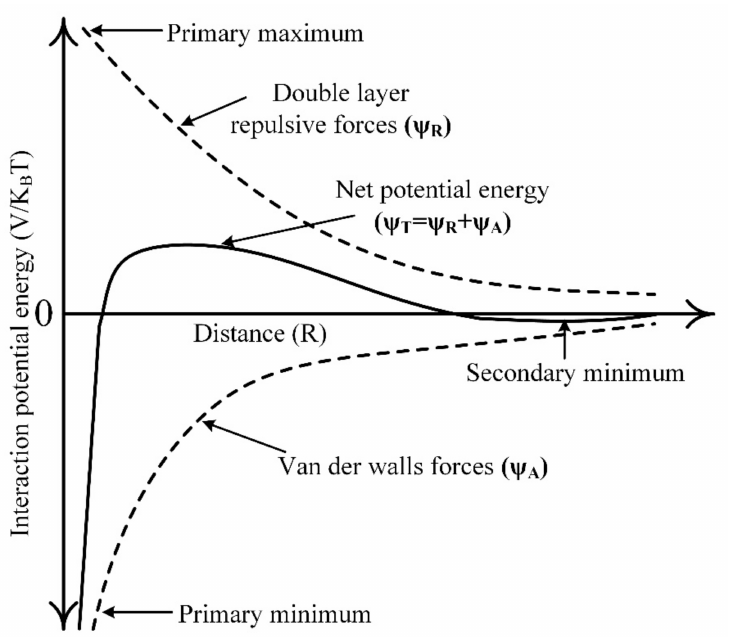
Figure 4. Potential energy interaction as a function of inter-molecular distance.